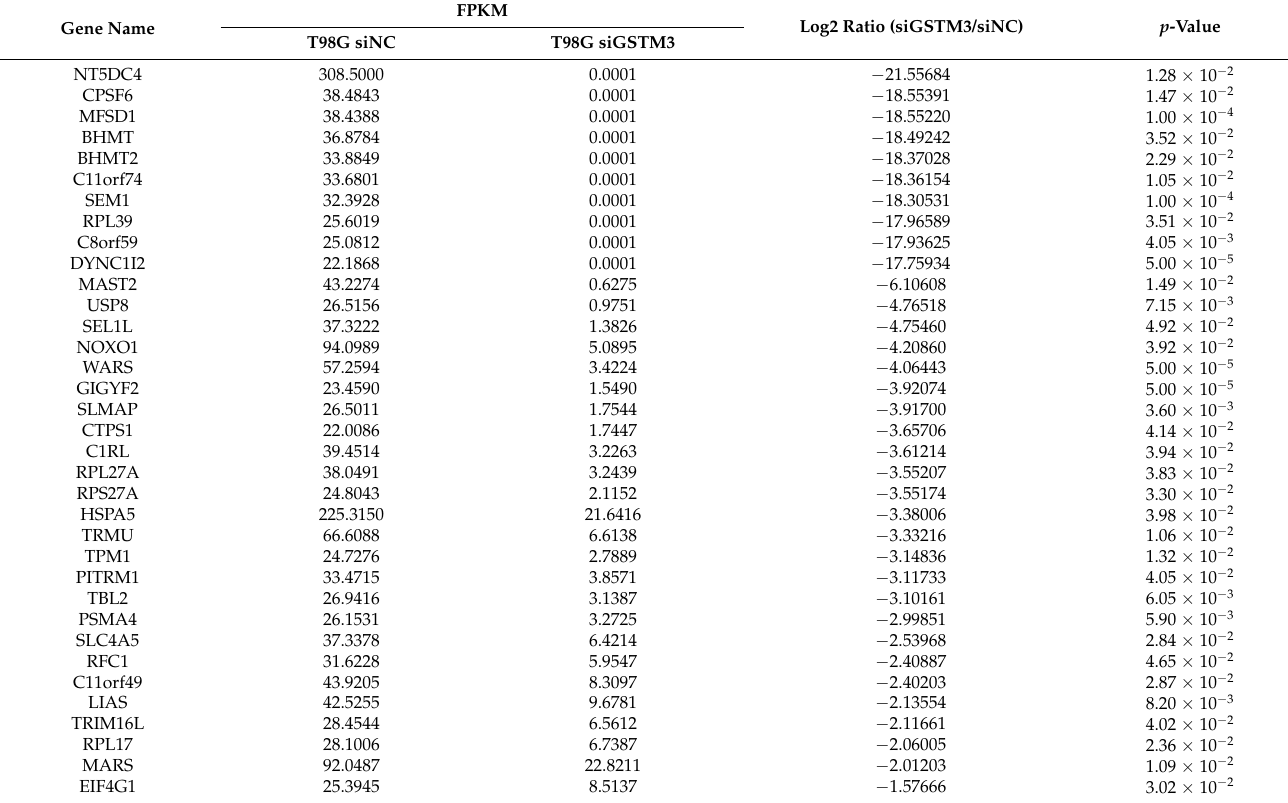
Table 2. The downregulated mRNAs revealed in GSTM3 knockdown